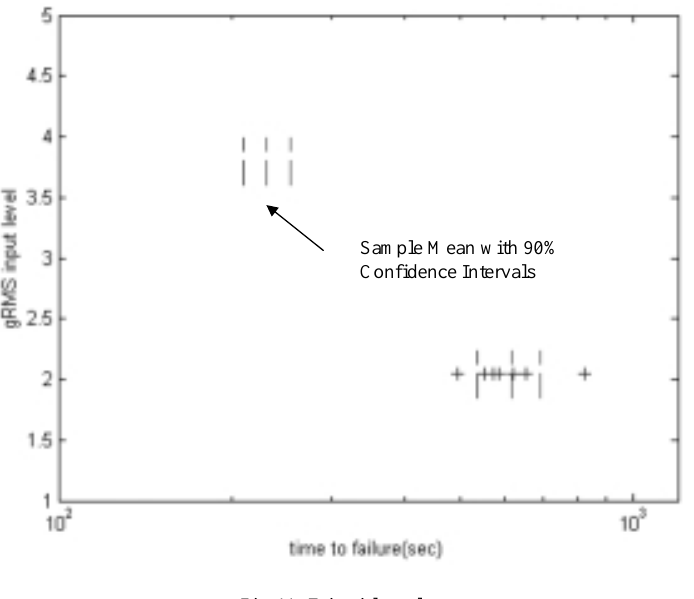
Fig. 11. Tri-axial